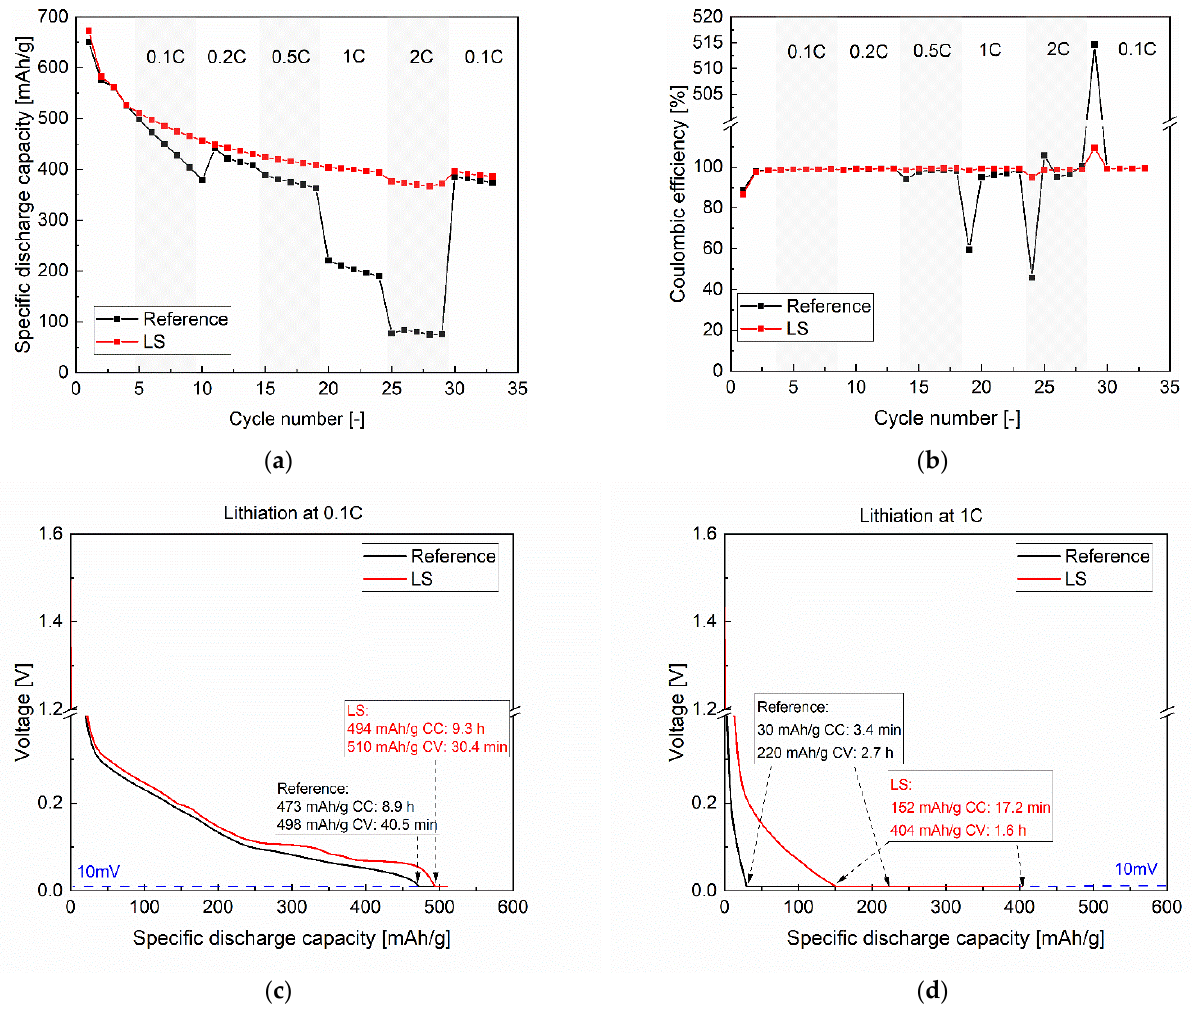
Figure 4. Results from galvanostatic measurements of cells with structured (LS) and unstructured (reference) electrodes: ( a ) specific discharge capacity as function of C-rate in rate capability tests, ( b ) corresponding coulombic efficiency, ( c ) voltage drop as function of specific discharge capacity by applying 0.1C, and ( d ) 1C (cccv-testing procedure was applied during the discharging process).